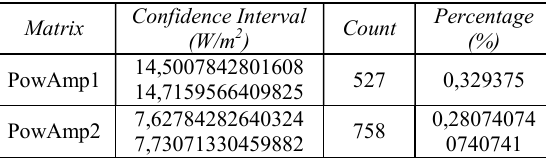
Table 5. Statistical Validation